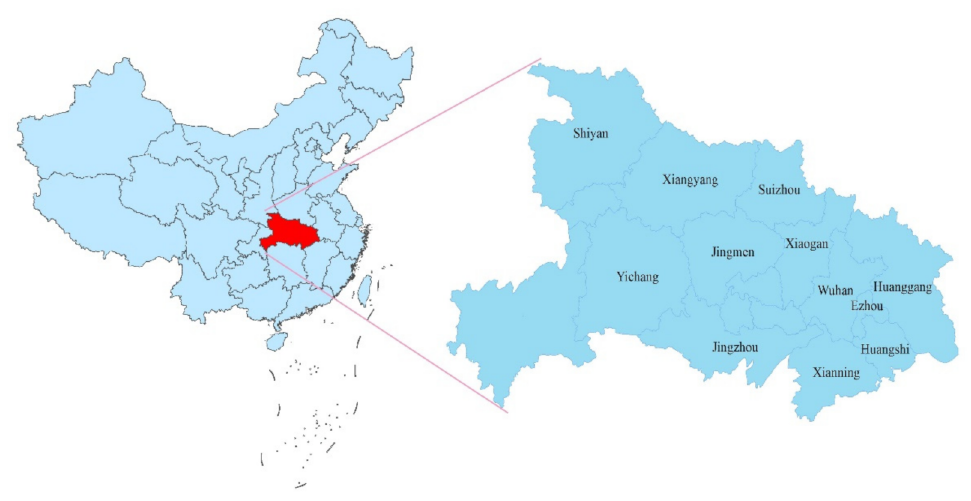
Figure 1. The position of Hubei in